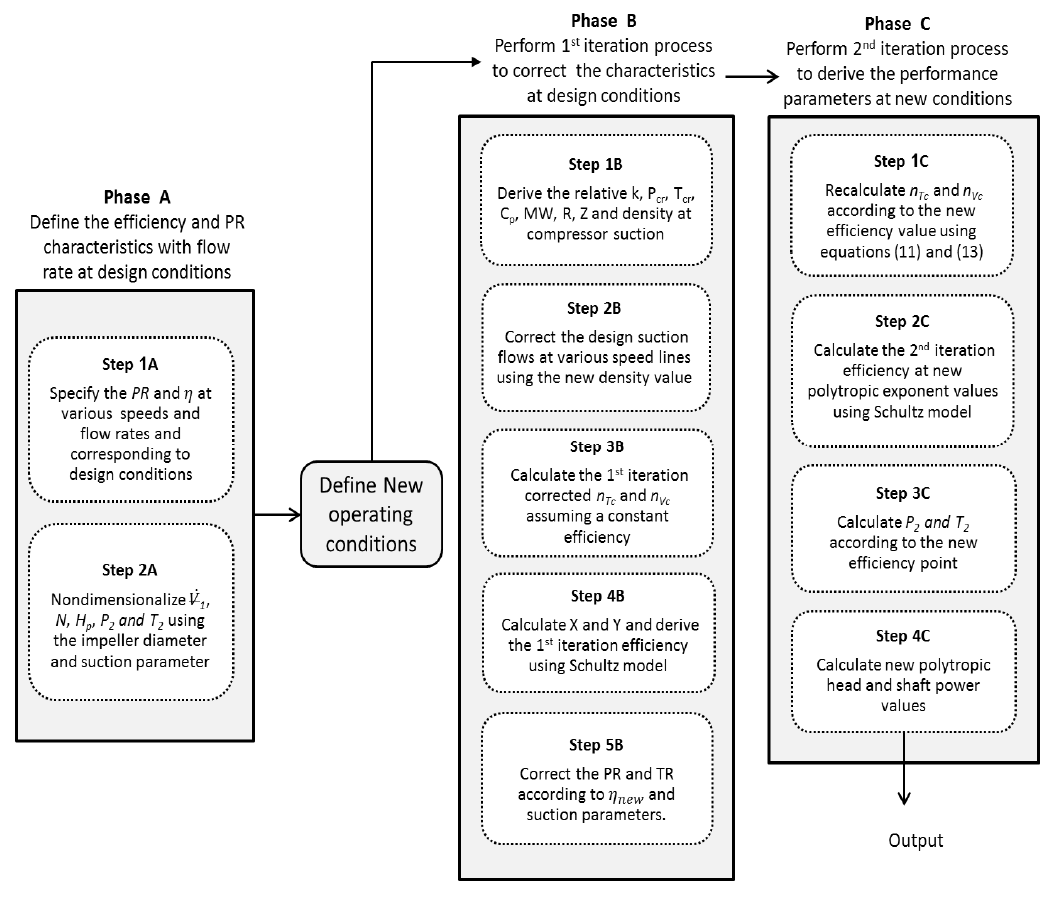
Figure 1. Scheme of developed